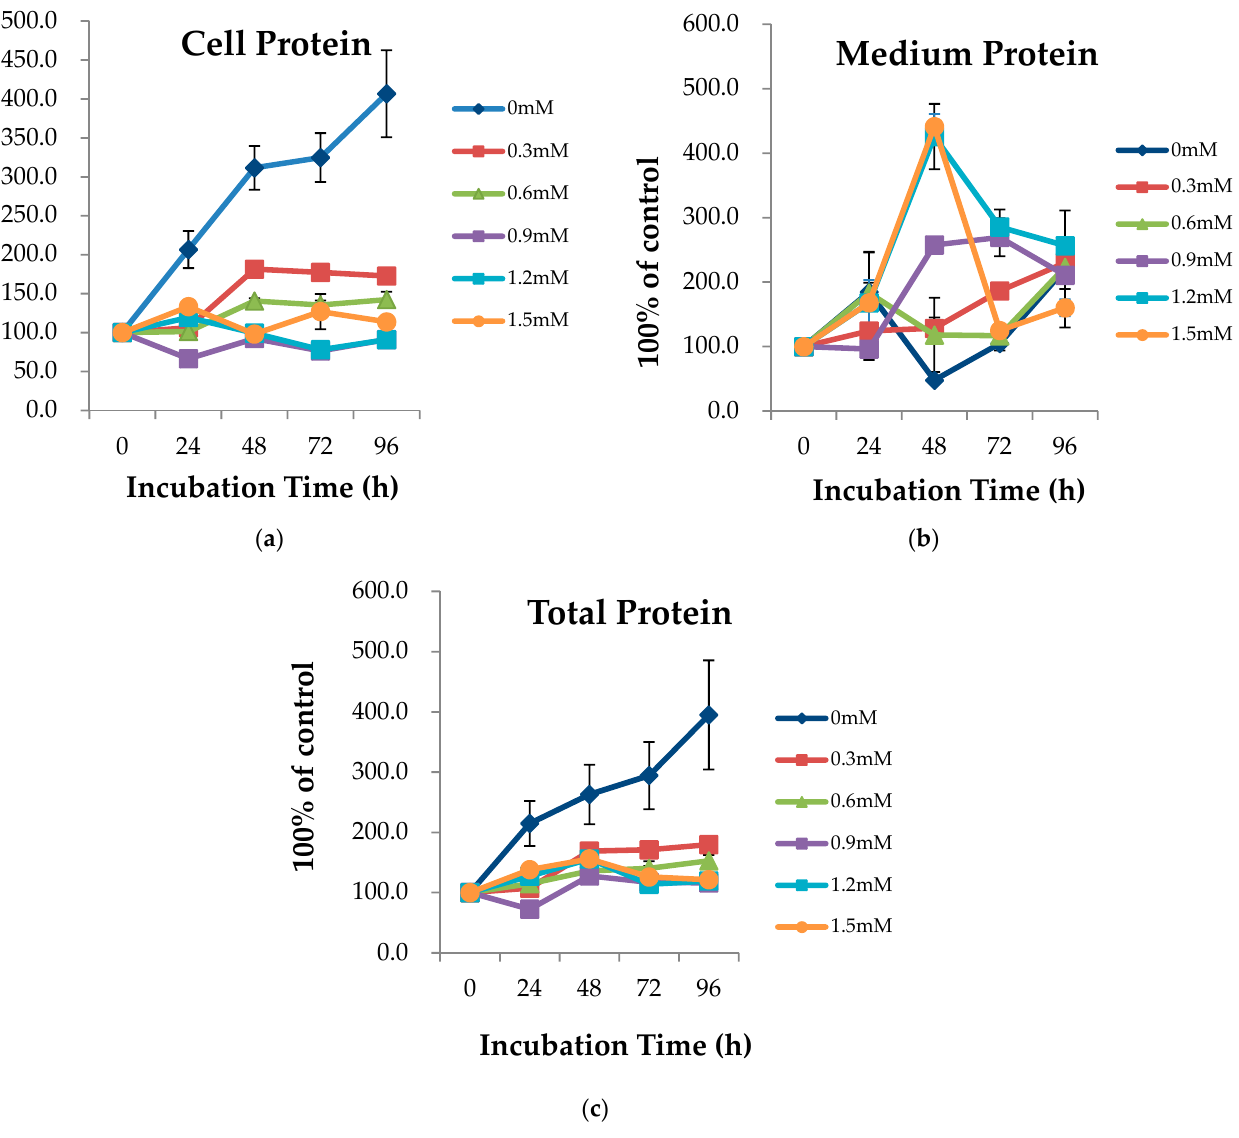
Figure 1. Relative protein content: ( a ) cell protein quantity, ( b ) medium protein quantity, and ( c ) total protein quantity (cell and medium) in bovine mammary epithelial (MAC-T) cells incubated with different levels of L-Trp (0, 0.3, 0.6, 0.9, 1.2, 1.5 mM) for 0, 24, 48, 72, and 96 h. Values are expressed as means ± SE ( n = 6 per group).